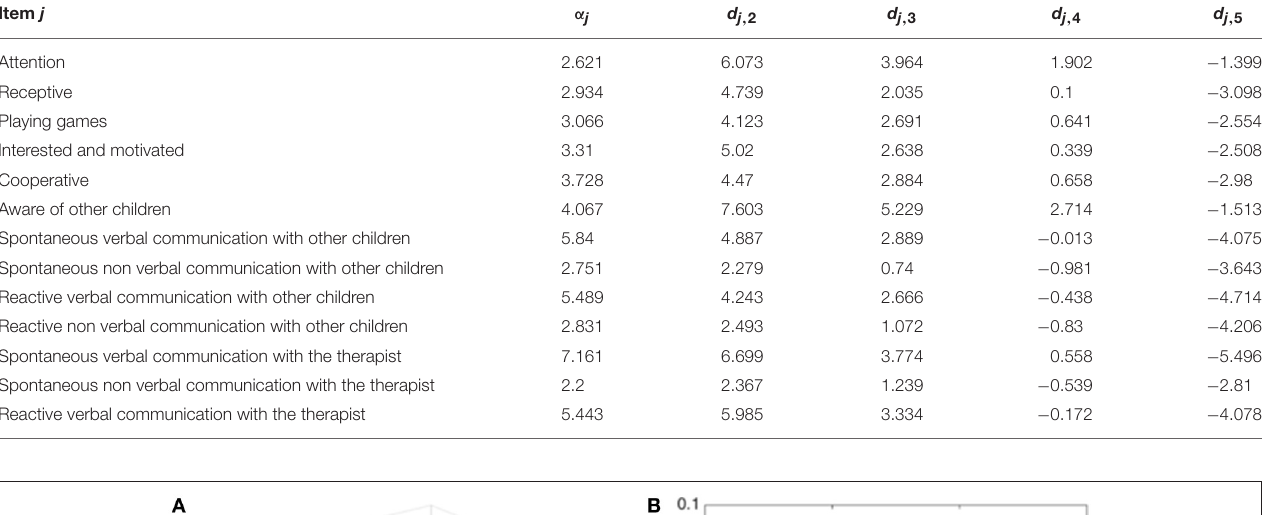
TABLE 4 | Discrimination α j and intercepts for each Likert score. Item j